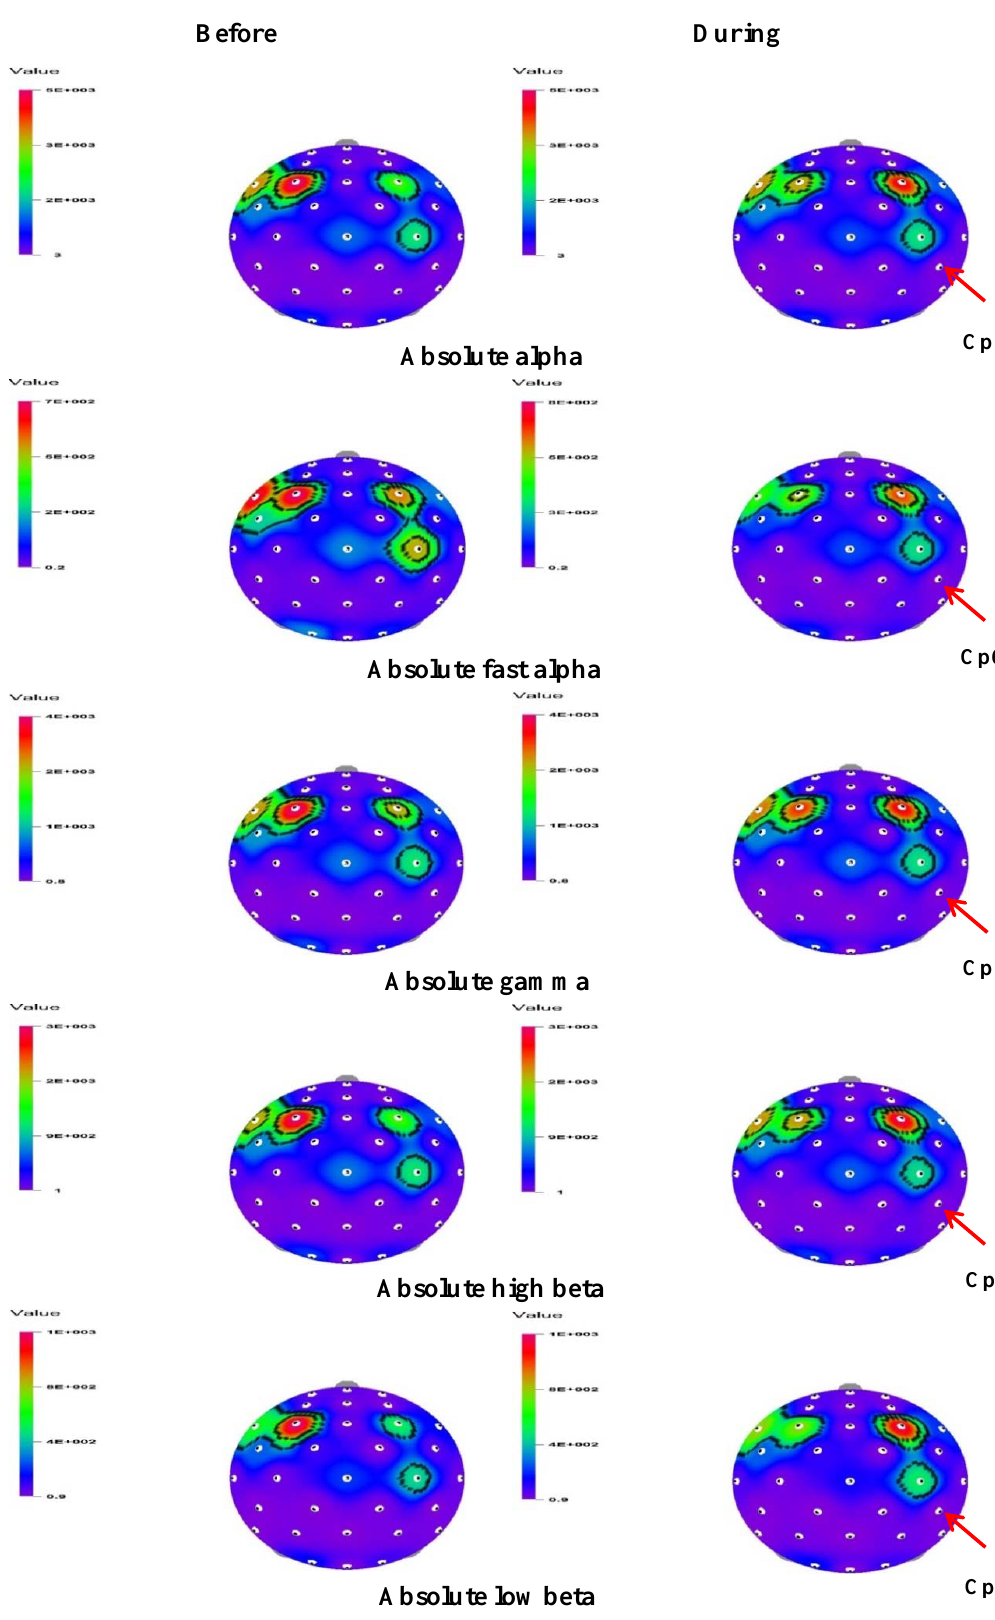
Figure 2. The t-mapping of EEG changes (absolute waves) before and during the inhalation of geosmin in both genders. Arrows show the significant changes in the region during the inhalation of